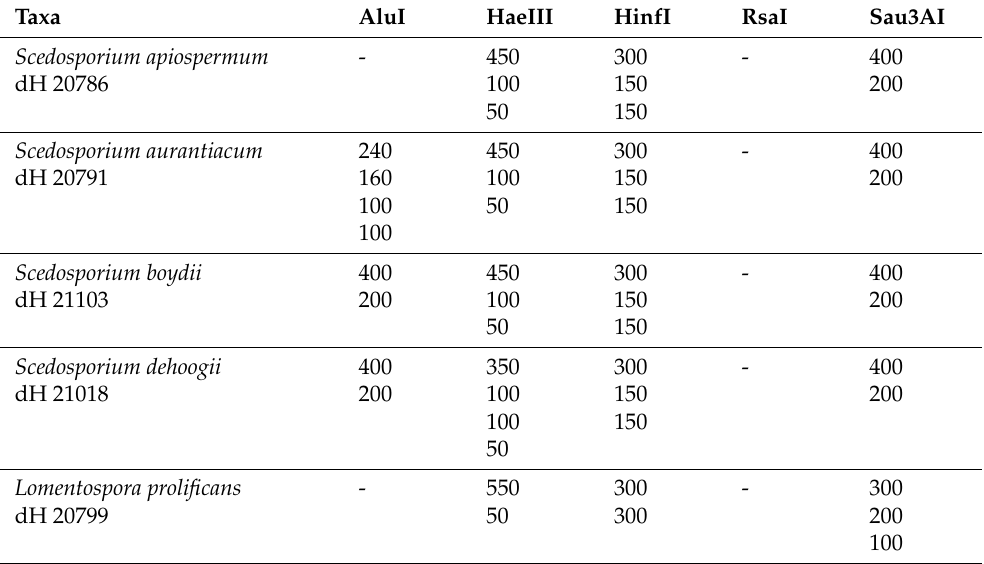
Table 1. Fragment sizes (bp) after digestion with enzymes AluI, HaeIII, HinfI, RsaI, and Sau3AI for reference